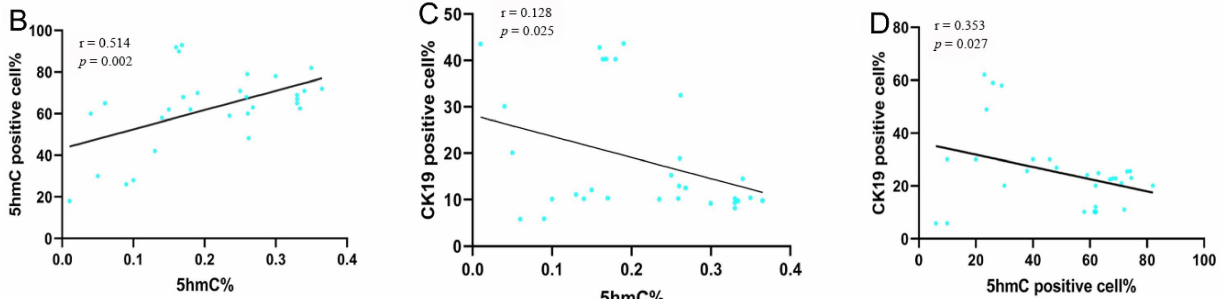
Figure 3. The 5hmC and CK19 IHC staining in metastasis SHCC tumor tissues and para-tumor tissues. Typical image for 5hmC and CK19 staining of metastasis SHCC samples and normal tissue (paired tissue samples from same patient) ( A ). Pearson’s correlation of 5hmC nuclear positive cells with global 5hmC content ( B ). Pearson’s correlation of CK19 cells with global 5hmC content ( C ). Pearson correlation of CK19 with 5hmC nuclear positive cells ( D ). Scale bars denote 200 µ m.